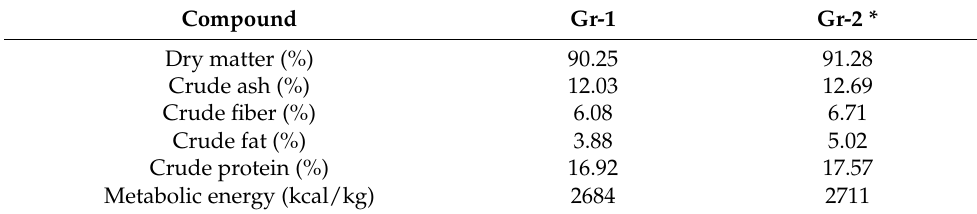
Table 1. Nutrient composition of feed mixtures for laying hens.